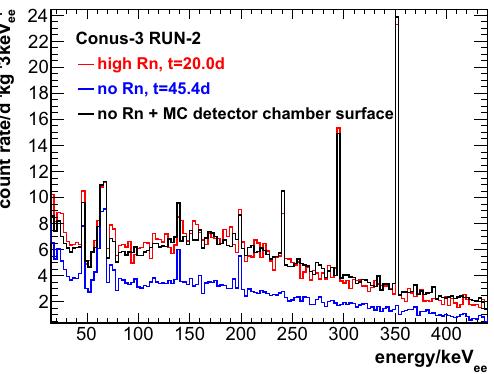
Fig. 17 The relative development of the Rn activity over time in comparison to the relative integral count rate of C1 in [20,440]keV ee is shown during the commissioning at KBR before the beginning of RUN-1 in 2018. Before the start of the flushing with air from breathing air bottles that have been stored long enough for the Rn to decay away, a clear correlation is seen. During the flushing, a low and constant background count rate is